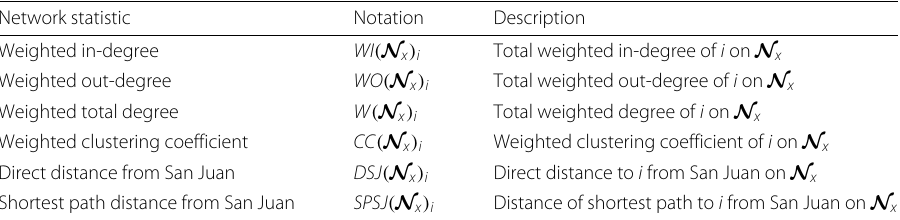
Table 4 Node-level statistics of node i given inter-city network N x Network